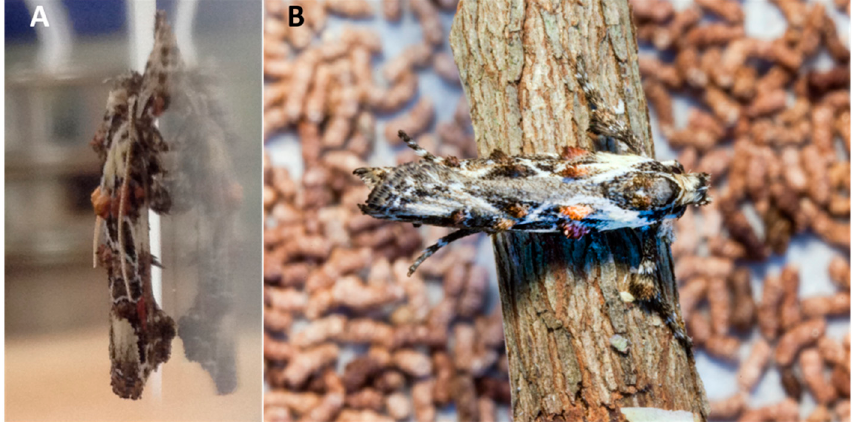
Figure 4. ( A ) Lateral view of a newly emerged Casmara subagronoma adult (photo K.L. Barr). ( B ) Dorsal view of a newly emerged adult resting on the stem, its last larval instar bored and from which the adult exited (larval ID 2014-1002-96). Frass is visible in the background (photo J.W. Lotz).